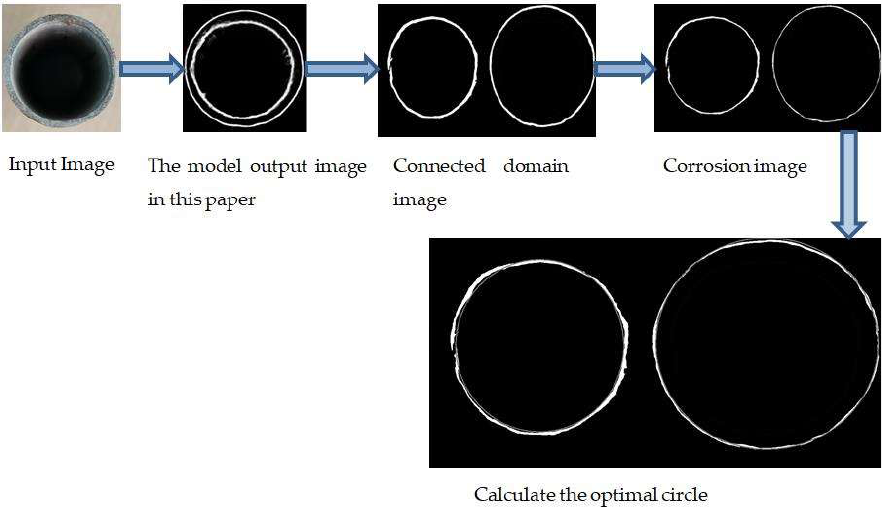
Figure 2. Flowchart of the Hough circle detection method.